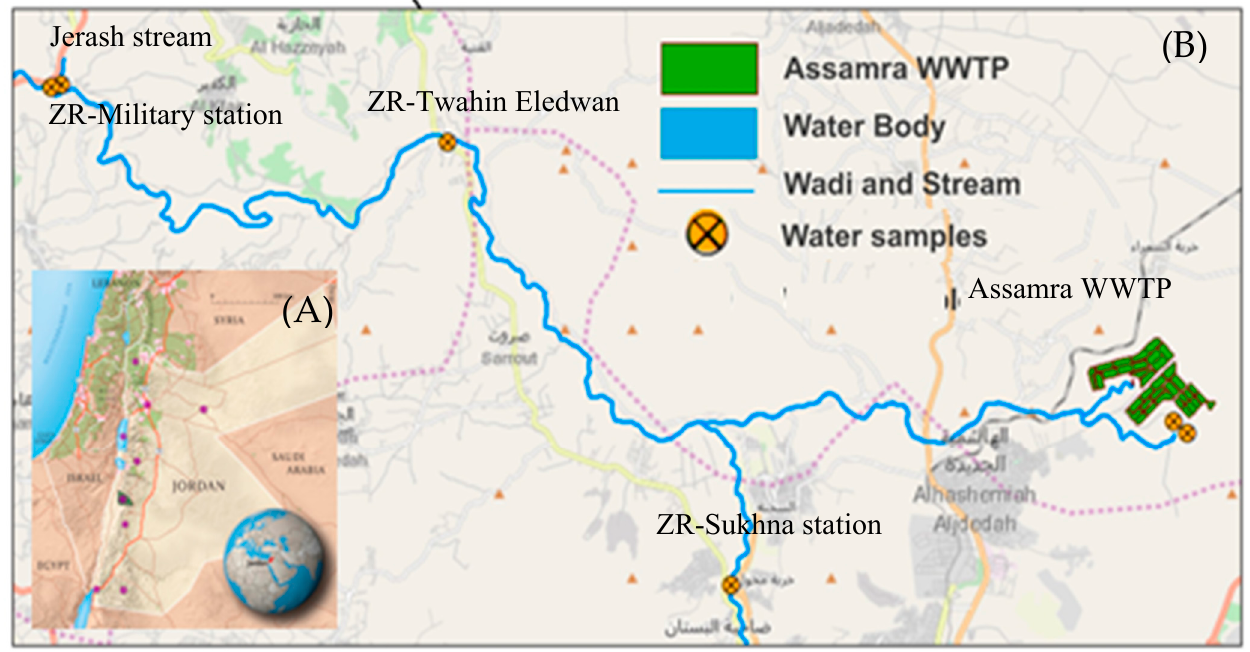
Figure 1. ( A ) Location of the Zarqa River (ZR) basin in Jordan. ( B ) Sampling sites for Assamra wastewater treatment plant (WWTP) influent and effluent ( n = 4) and for river water at Sukhna station ( n = 2), Twahin Eledwan station ( n = 2), Military station ( n = 2), and Jerash stream ( n = 2). Part A of the diagram is modified from Shigei et al. (2020).